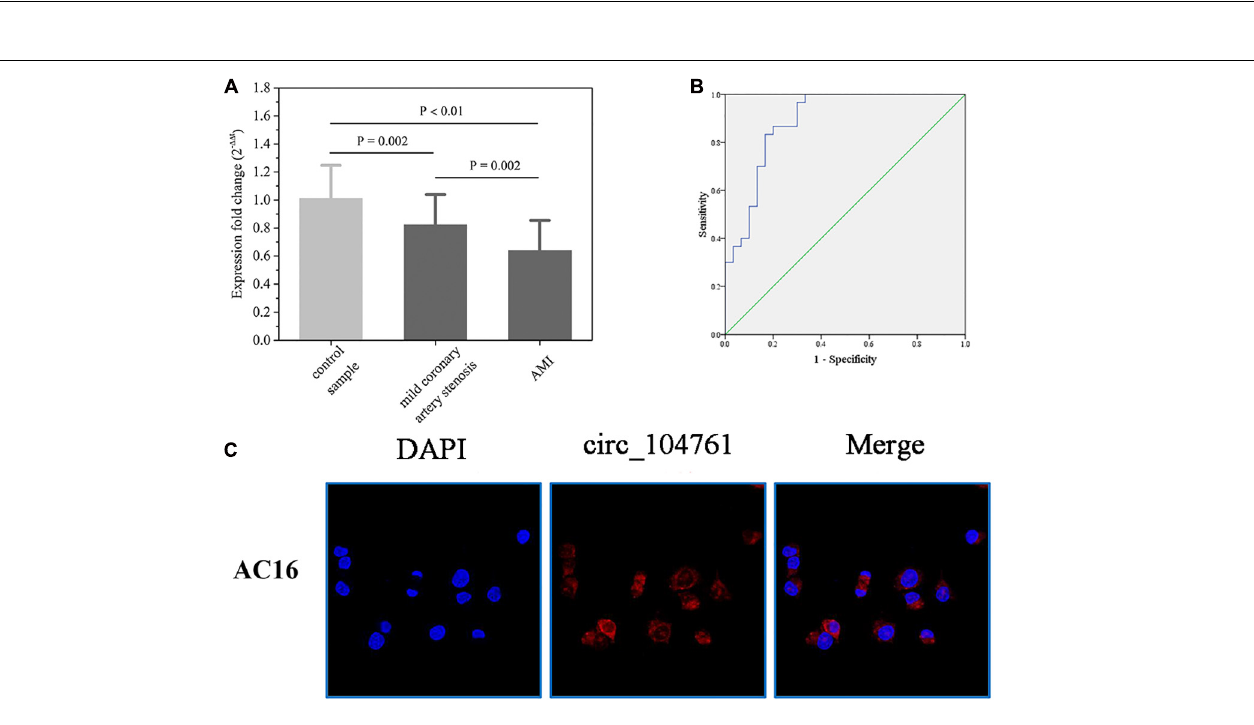
FIGURE 5 | The relative expression of circRNA _104761 in larger scale and the ROC curve analysis. (A) Verification of the relative expression level of down-regulated circRNA _104761 by RT-qPCR in expanded sample test. (B) ROC curve analysis evaluating the diagnostic value of validated circRNA_104761 for AMI. (C) RNA-FISH assays determined the subcellular localization of circRNA_104761 in AC16. Results are represented as means ± standard deviation (SD). Data shown in the graph was analyzed by independent sample t -tests with a significance level of 95%.